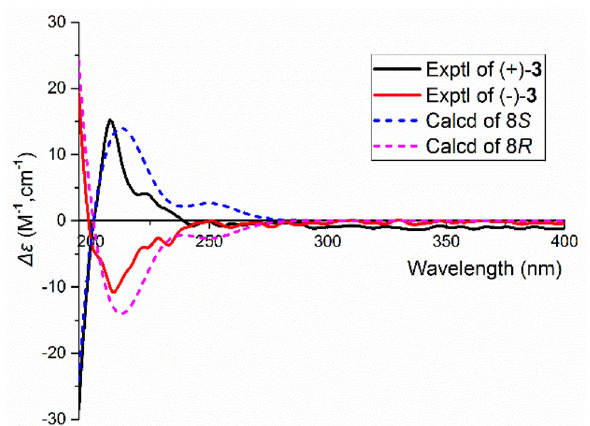
Fig. 3 Comparison of calculated ECD spectra for (8 S )- 3 and (8 R )- 3 with the experimental spectra of (+) -3 and (−) -3 in MeOH. σ = 0.3 eV; shift = − 10 nm